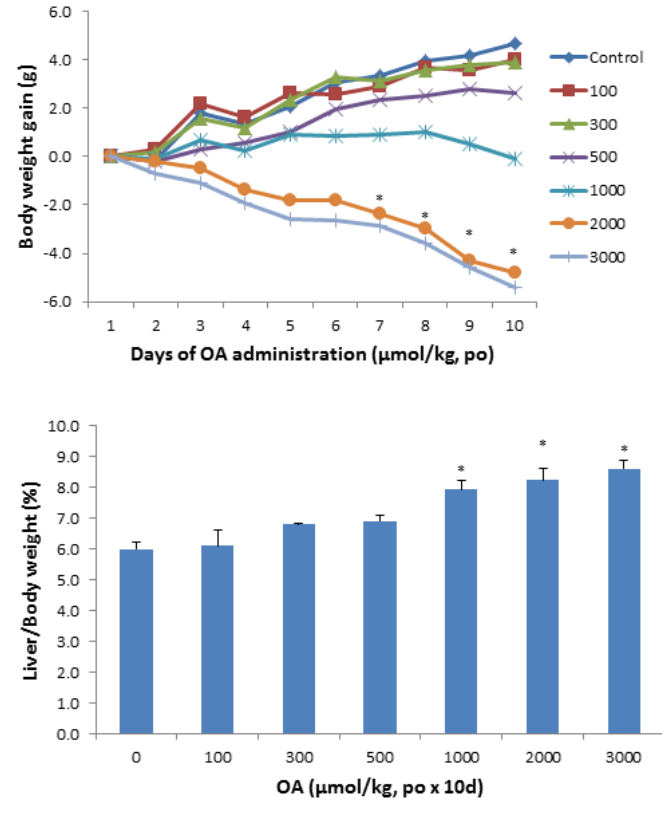
Figure 1. Effect of oral OA on body weight gain and liver index. Mice were gavaged OA at doses of 100–3,000 µmol/kg (equal to 45–1,350 mg/kg), once daily for 10 days. Animal body weights were recorded daily and the liver weights were recorded at the end of experiments. Data are mean ± SEM (n = 5–8). * Significantly different from control, p < 0.05.